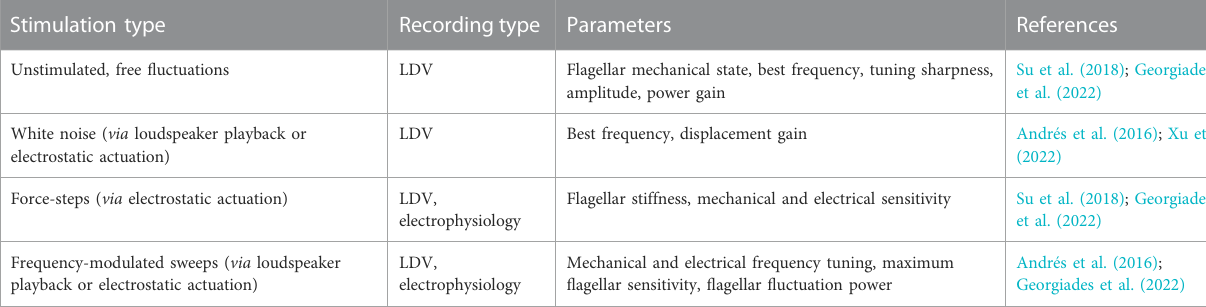
TABLE 1 Relevant auditory parameters to be analysed for auditory efferent